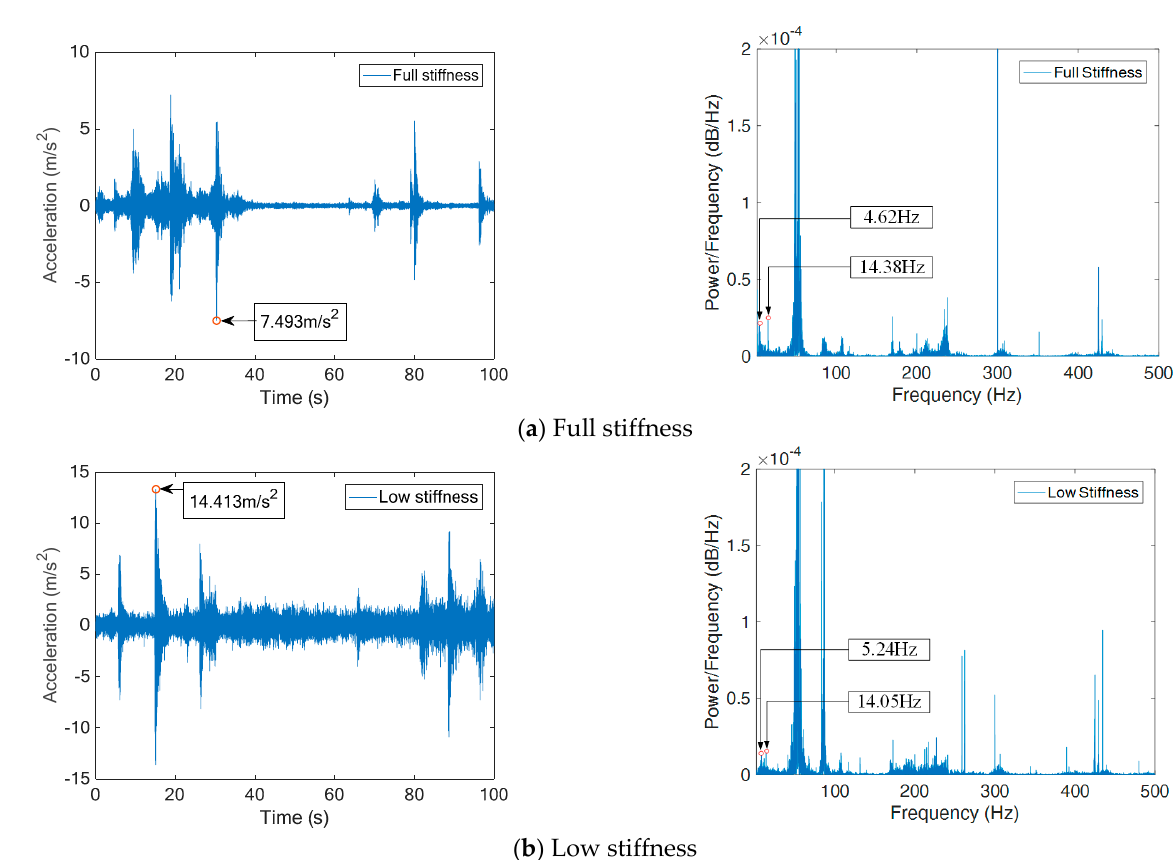
Figure 14. Effect of bridge stiffness on the vertical acceleration of the suspension bogie.